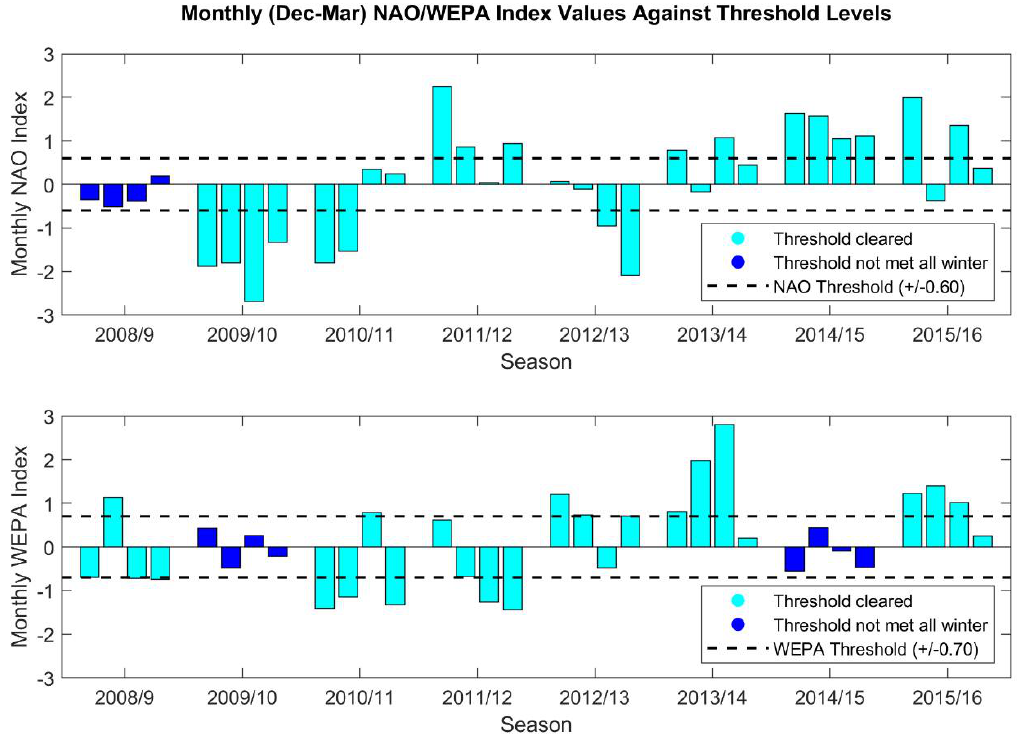
Figure 6. Shows the monthly NAO (top) and WEPA (bottom) index values for the eight winter seasons modelled in this study, with each year representing the December–March months. Dark blue colouring indicates a season where none of the four months in the selected winter breached the index threshold, therefore the SF-NAO/SF-WEPA forecast methodology was identical to SF-Uninf for those runs.